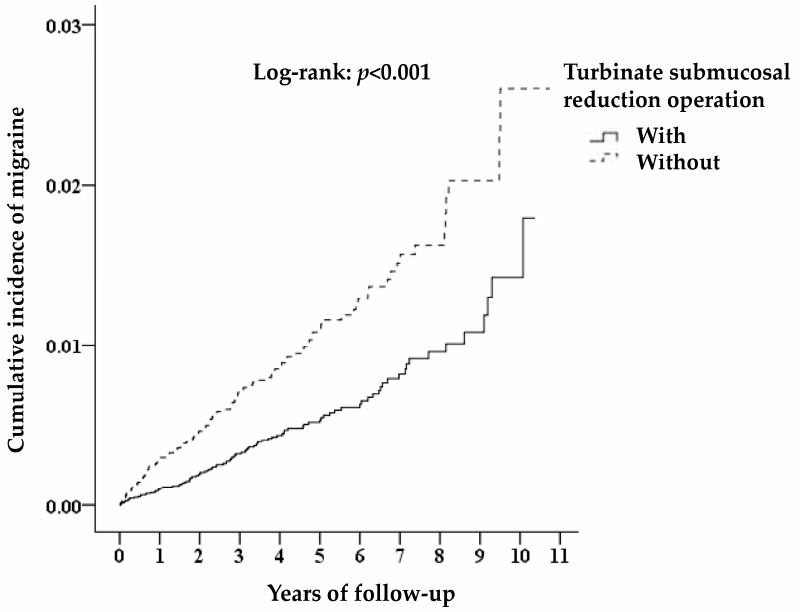
Figure 2. Kaplan–Meier analysis of the cumulative risk of migraine among chronic hypertrophic rhinitis patients stratified by turbinate submucosal reduction operation with the log-rank test. Male gender, younger age, and less comorbidity were common in those who received turbinate submucosal reduction